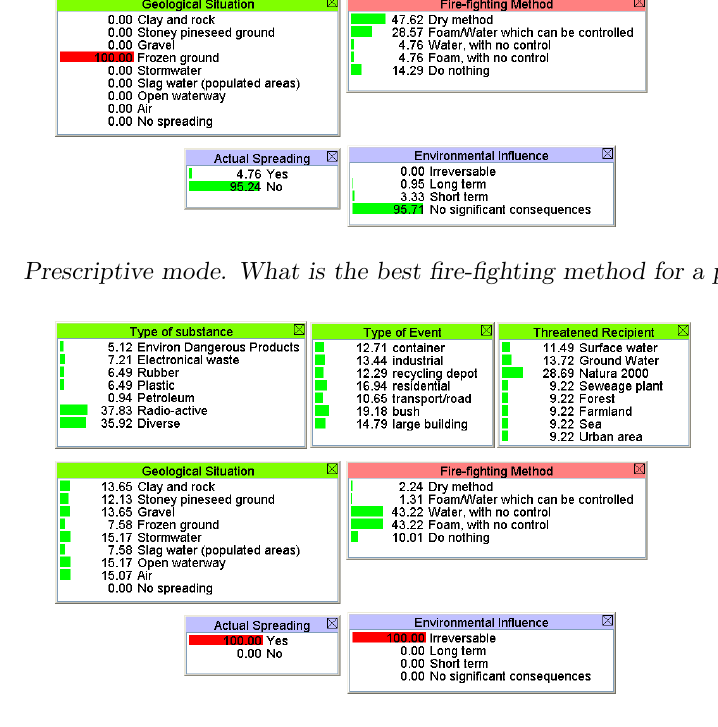
Figure 12: Example of Diagnostic mode: Under what circumstances can irreversible environ- mental damage be